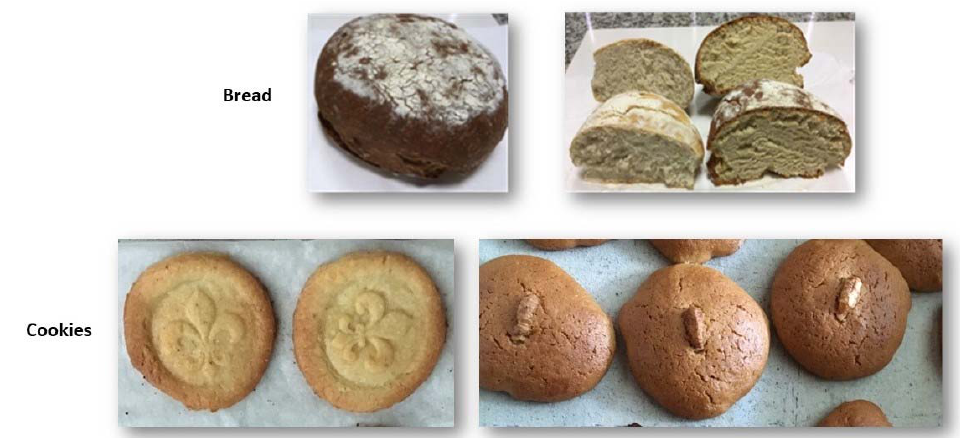
Figure 1. Bakery products that include drone